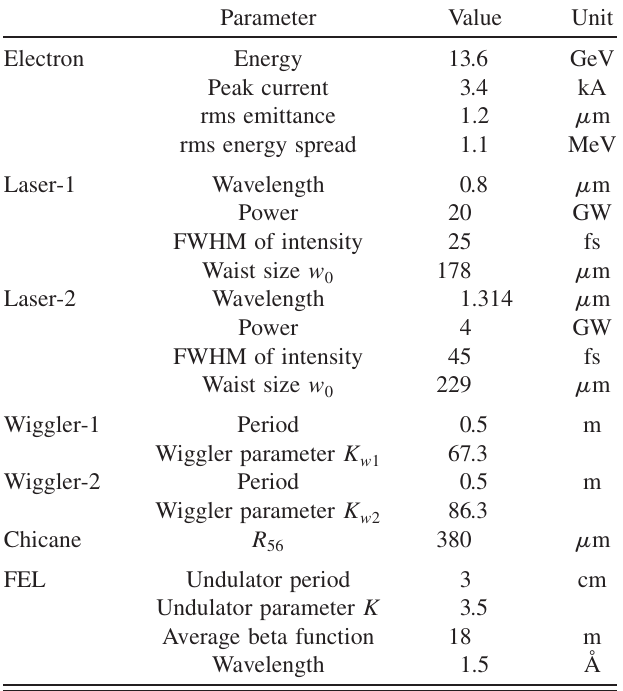
TABLE I. Main parameters for electrons, lasers and wigglers.